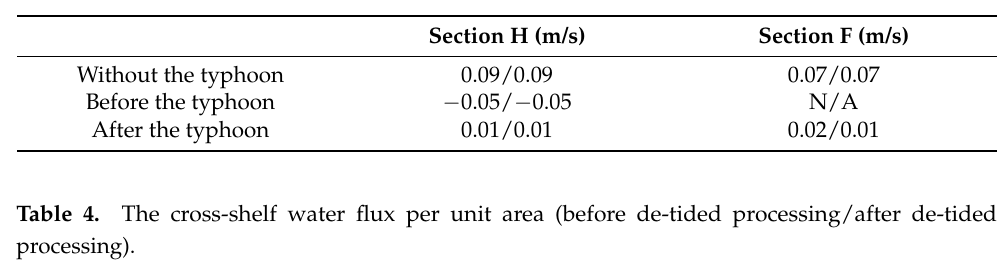
Table 3. The along-shore water flux per unit area (before de-tided processing/after de-tided processing).